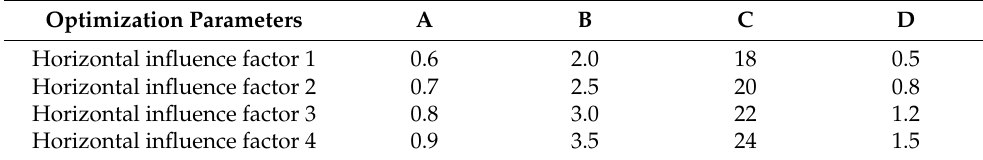
Table 3. Parameters of the